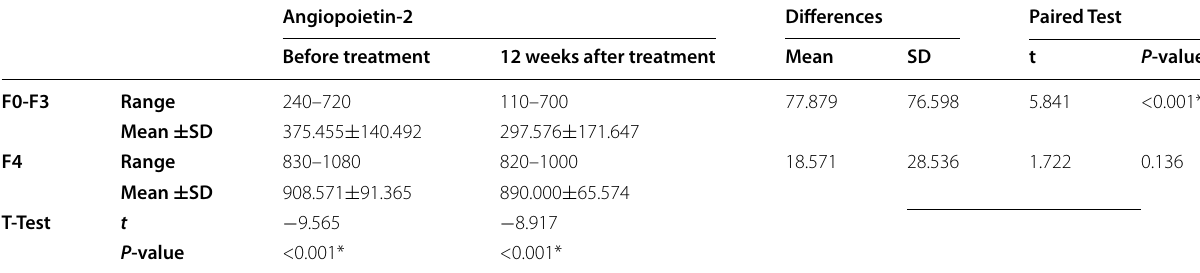
Table 6 Comparison between levels of Angiopoietin-2 before and 12 weeks after EOT according to fibrosis stages